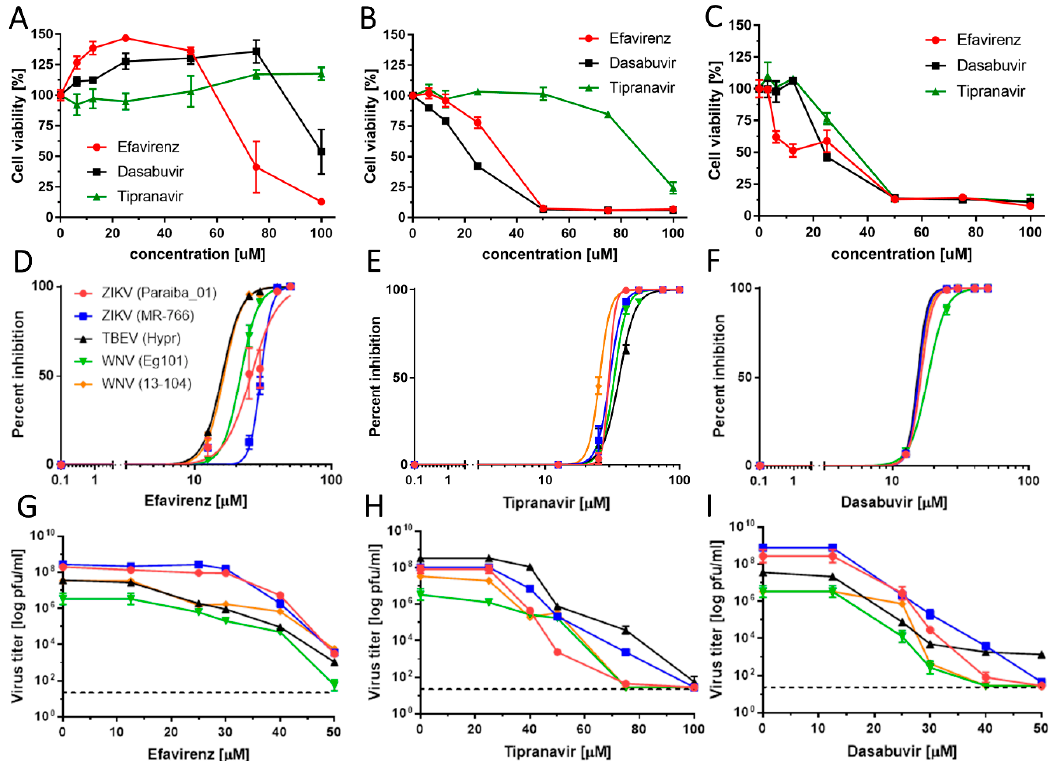
Figure 4. Cytotoxicity of efavirenz, tipranavir, and dasabuvir in Vero ( A ), UKF-NB-4 ( B ), and Human brain cortical astrocyte (HBCA) ( C ) cells, within the compound concentration range 0–100 µM, at 72 h post-treatment. ( D – F ) Virus titer inhibition curves of the indicated flaviviruses in Vero cells in the presence of serial dilutions of efavirenz ( D ), tipranavir ( E ), and dasabuvir ( F ) in a pretreatment assay. Dose-dependent effect of efavirenz ( G ), tipranavir ( H ), and dasabuvir ( I ) on virus titers in Vero cells in a pretreatment assay (legends as in D ).